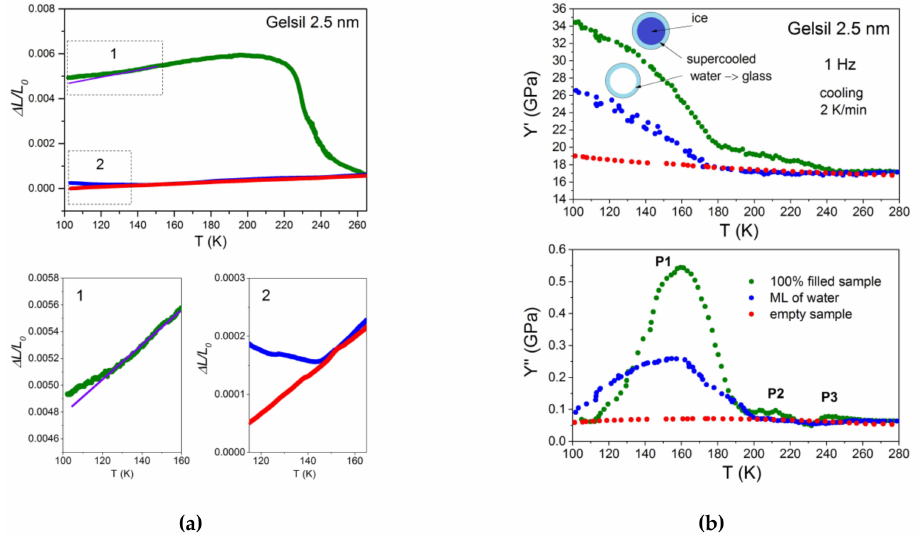
Figure 1. ( a ) Temperature dependencies of thermal expansion. Green (fully filled sample), blue (partly filled), red (empty sample). ( b ) real (Y (cid:48) ) and imaginary (Y (cid:48)(cid:48) ) parts of the complex Young´s modulus of water in Gelsil 2.5 nm, measured at heating (heating rate 2 K / min) after the sample was slowly (2 K / min) cooled to 80 K. The results of samples fully filled with water (green), partly filled (blue) and empty samples (red) are